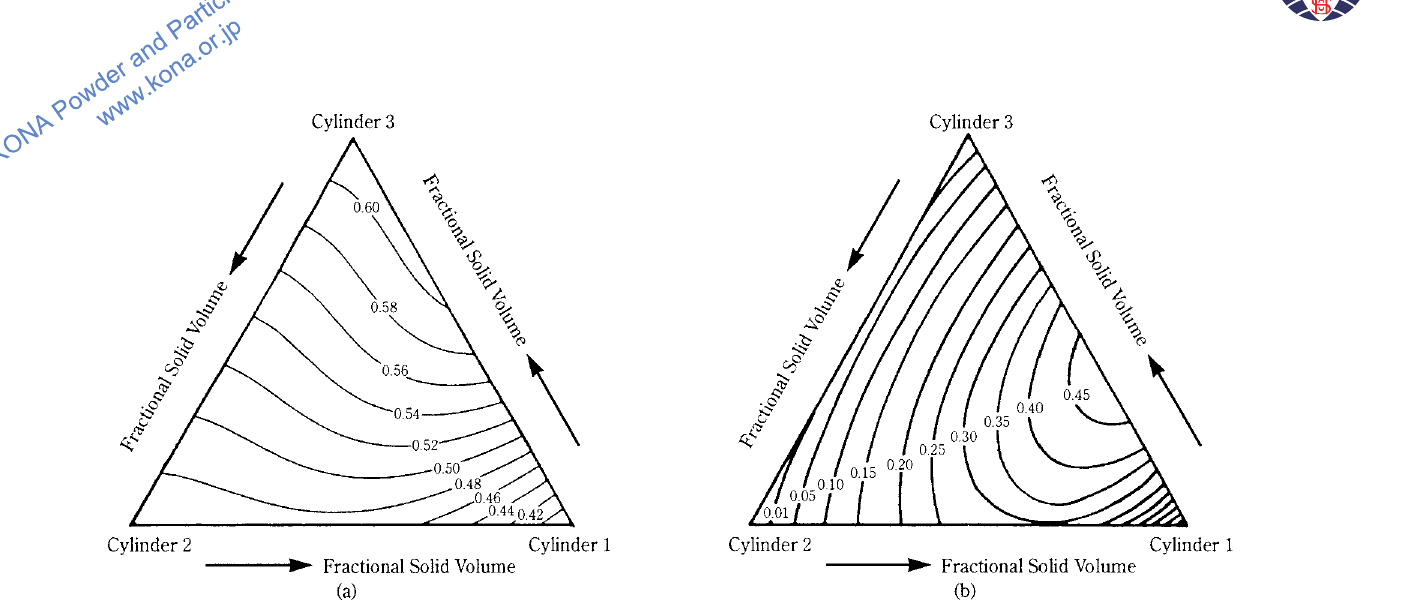
Fig. 13 The measured packing results for a ternary system of cylindrical particles in terms of: (a). packing density (=1-porosity); (b), specific volume variation, with particle sizes given as (DxL)l=19.374x0.071, (DxL)2=4.0x7.5, (DxL):J=6.0x2.0 mm; and initial specific volumes as Vt=2.653, Vz=2.155, VJ=1.616 [16].